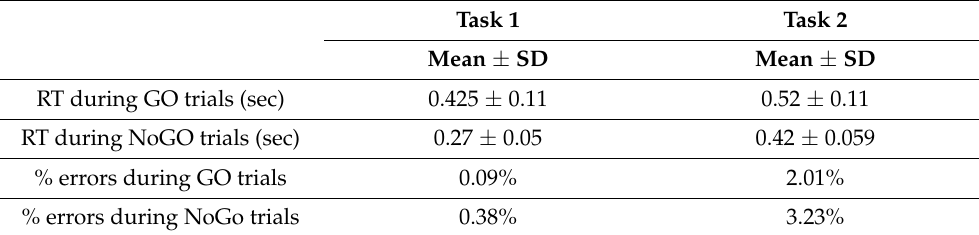
Table 1. Behavioral